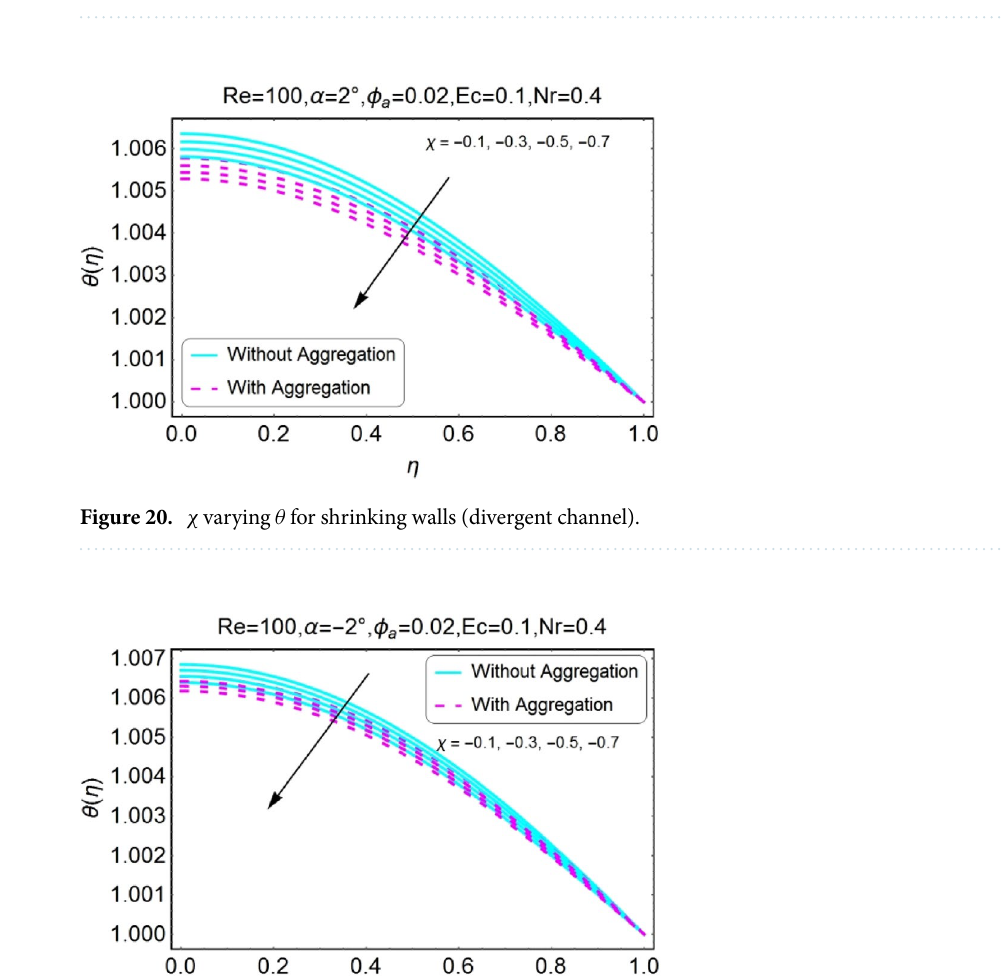
Figure 19. χ varying θ for stretching walls (convergent channel).